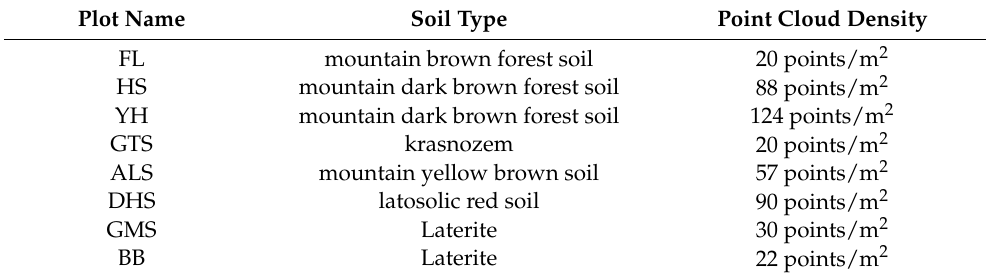
Table A1. Soil types of 8 plots.